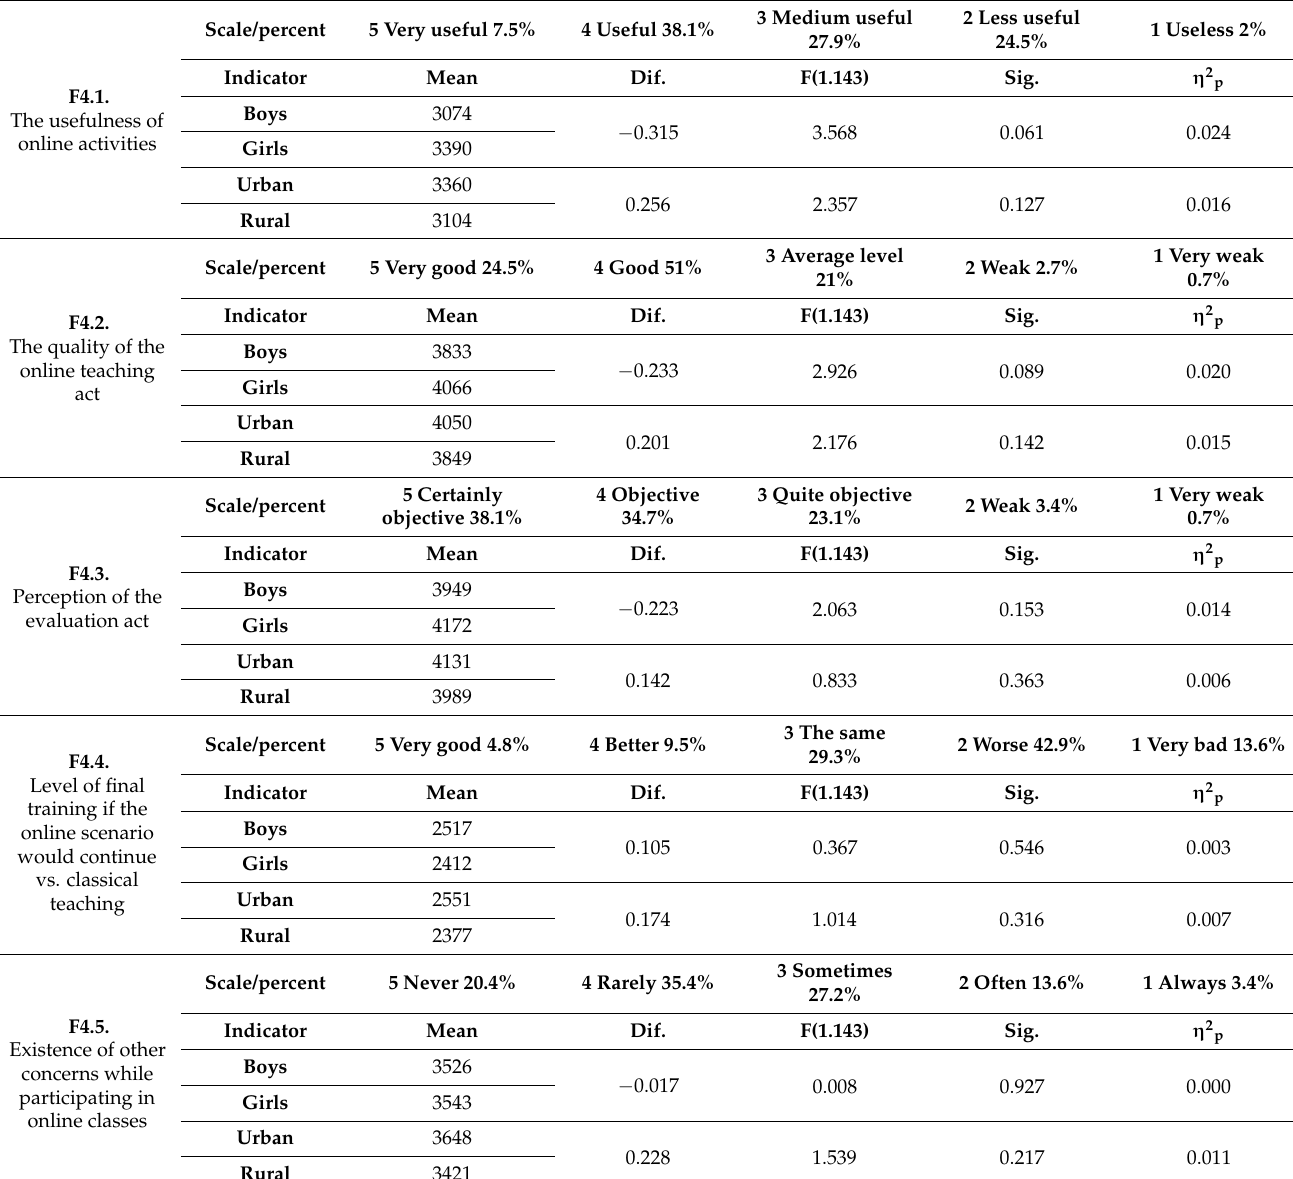
Table 10 indicates the outcomes of the questionnaire for the efficiency factor (univariate test). All these tables indicate the description of the items, the scores for each item on the Likert scale and the grade that accompanies them, separately on the four building factors of the questionnaire, as well as the percentage of students who prefer that score. The tables also present the average values by sex and area, the differences between the averages, the values of F with the corresponding significance thresholds and effect size expressed by partial eta squared ( η 2 p ). Table 10. The results of the questionnaire for the efficiency factor (univariate